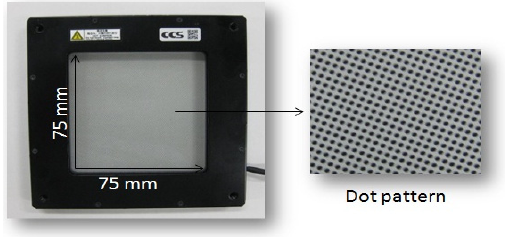
Figure 3. Flat dome light units (indirect